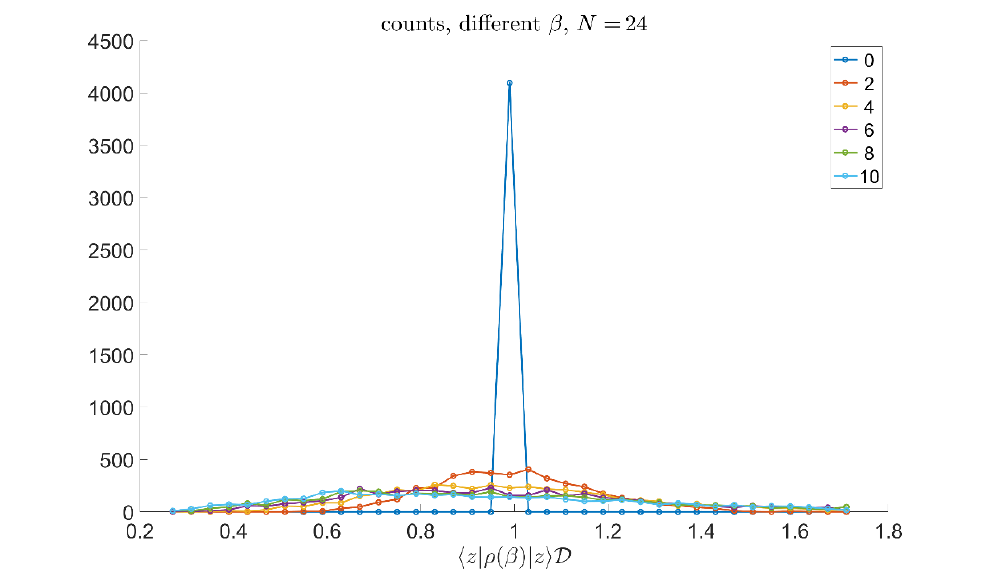
Figure 21 . Histogram of h s j (cid:26) ( (cid:12) ) j s iD for two coupled SYK clusters corresponding to L = 2 and N = 12. The di(cid:11)erent curves correspond to (cid:12) = 0 ; (cid:1) (cid:1) (cid:1) ; 10 in units with J 0 = 1.